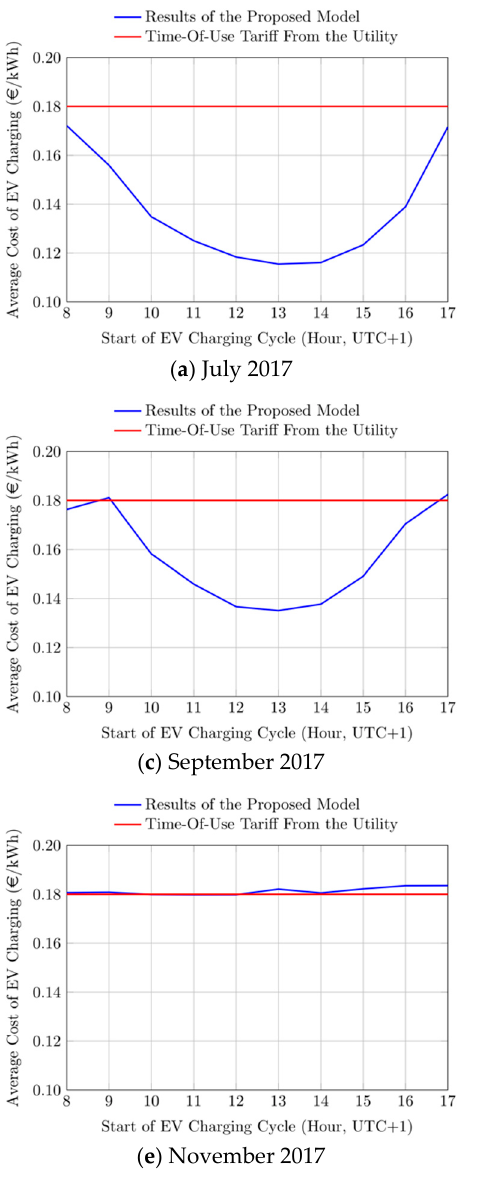
Figure 9. Monthly average cost of electric vehicle (EV) charging (€/kWh) from July to December 2017, as depicted from sub-figure ( a ) to sub-figure ( f ), respectively. The computed EV charging cost for each hour (blue line), is compared to the time-of-use (TOE) electricity tariff applied to the amount of energy purchased from the grid (red line). UTC: Universal Time Coordinated.